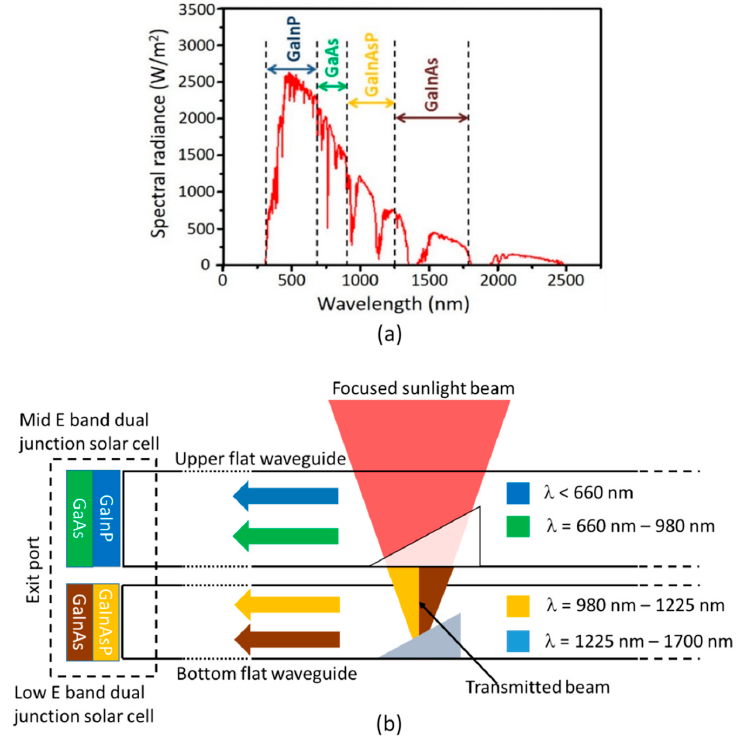
Figure 7. ( a ) Solar spectrum is divided into four bands corresponding to suitable solar cells. ( b ) Illustration of the solar cells at waveguide exit ports in association with other optical